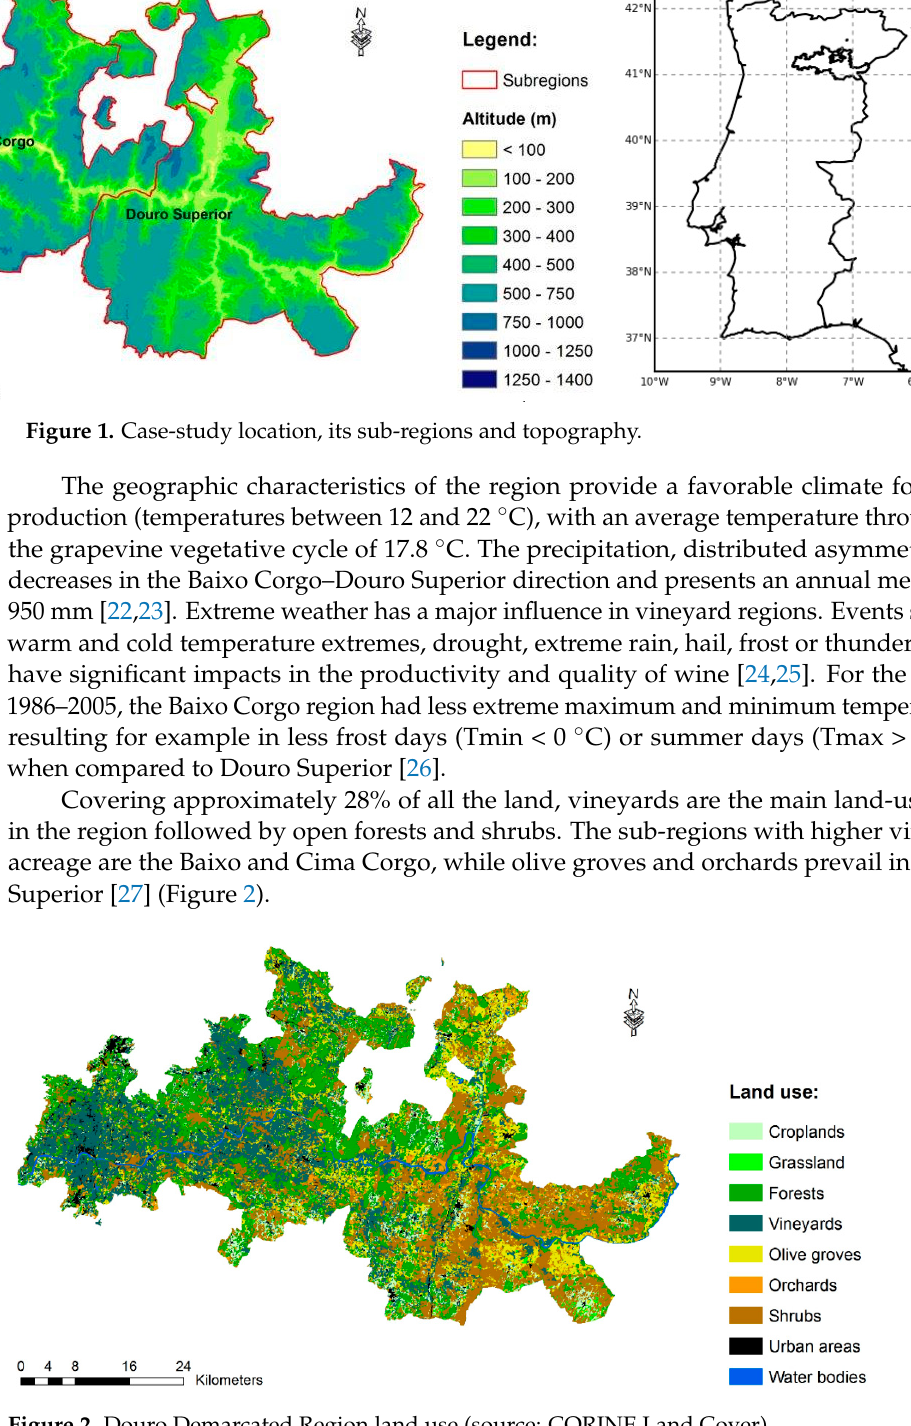
Figure 2. Douro Demarcated Region land use (source: CORINE Land Cover).